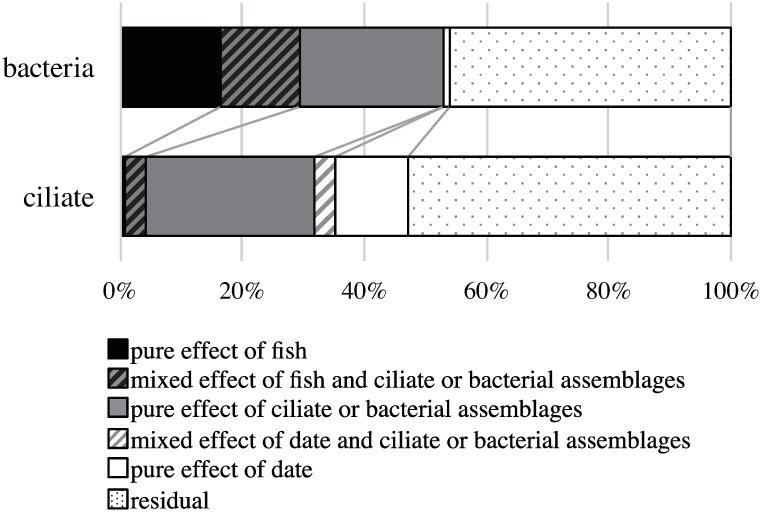
The results of variation partitioning in the Horn indices of microbial assemblages.The Horn indices of bacterial assemblages are partitioned by the sampling date, fish carcass and ciliophoran assemblages, and those of the ciliophoran assemblages by the sampling date, fish carcass and bacterial assemblages.